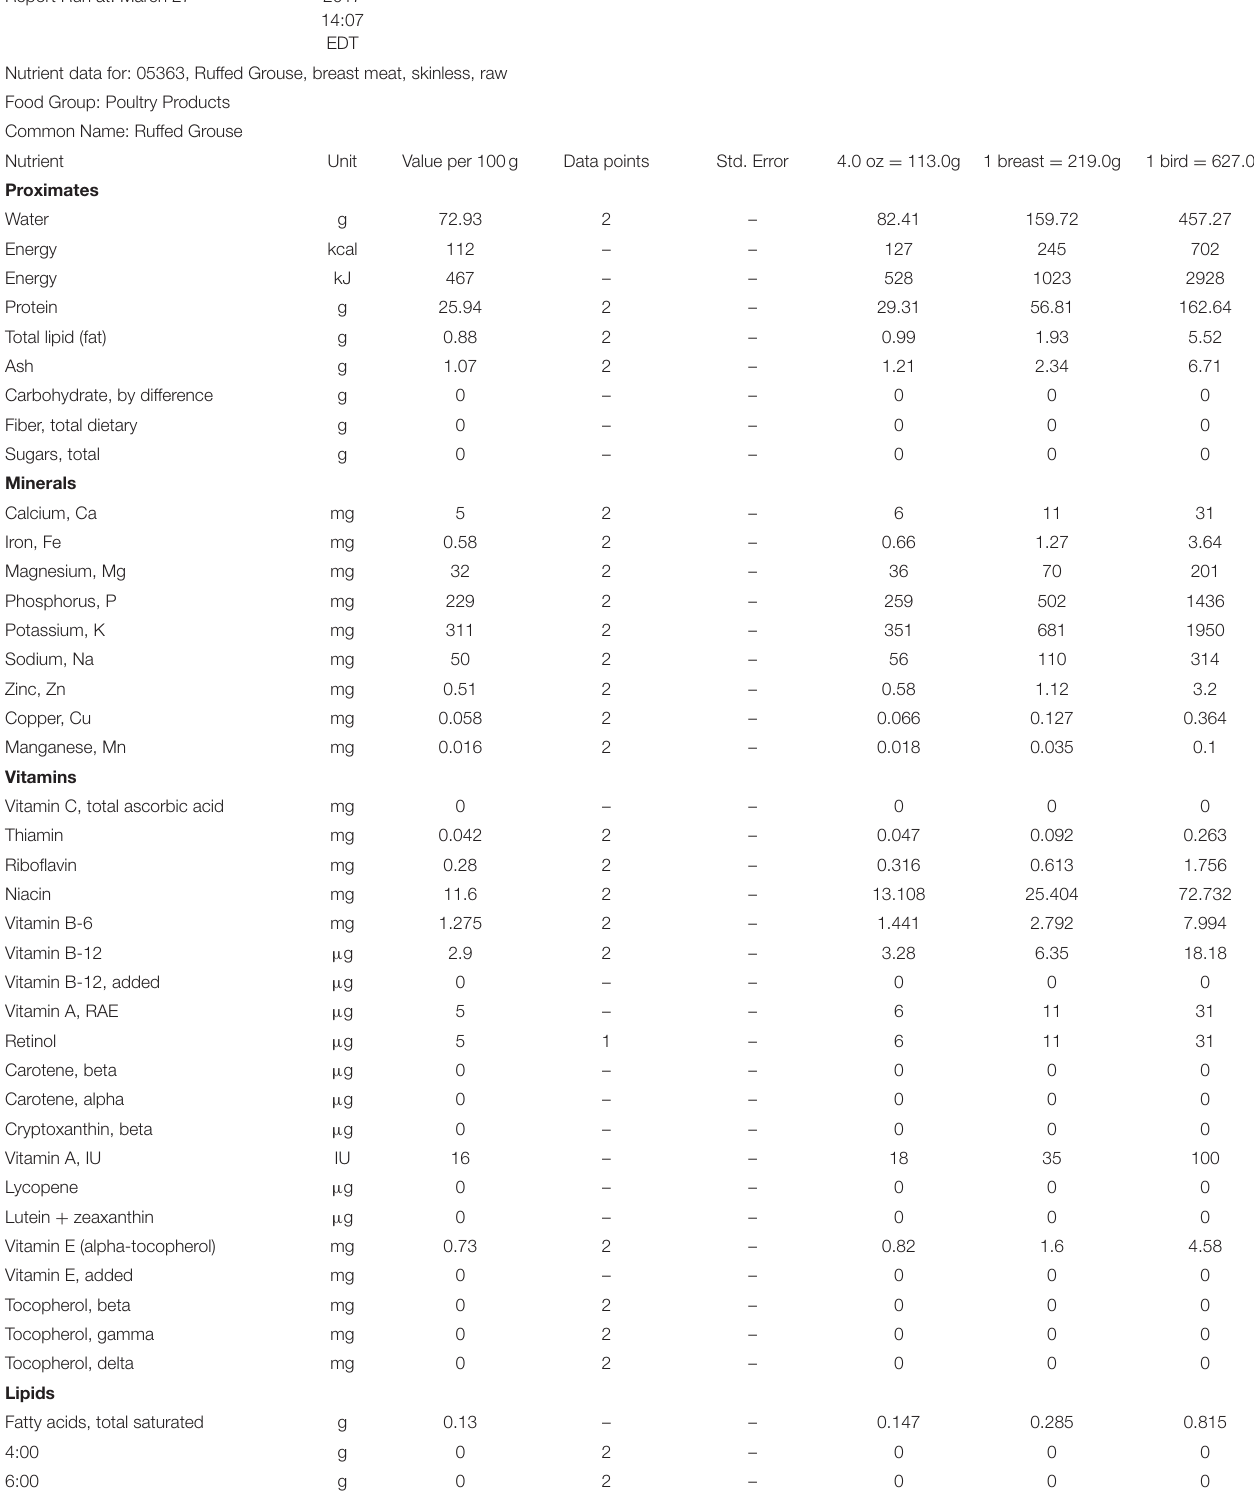
TABLE 3 | Profile for Ruffed